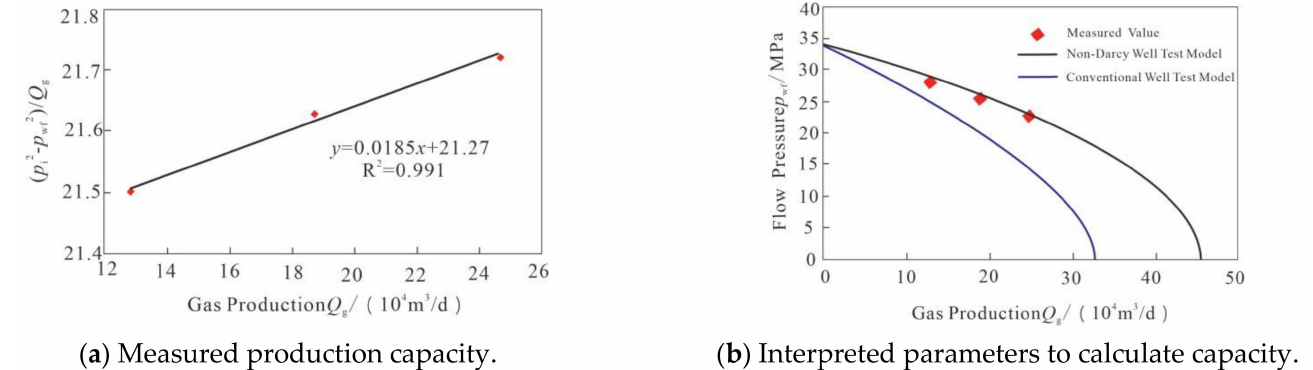
Figure 9. Comparison and verification of model interpretation